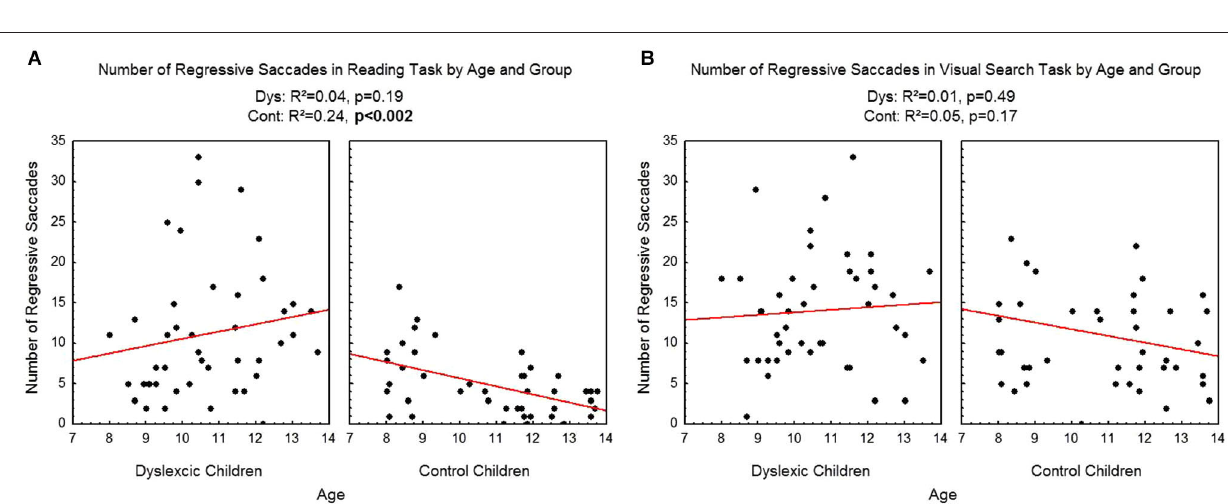
task ( R 2 = 0.05, p = 0.17). There is no effect of age on dyslexic group on reading ( R 2 = 0.04, p = 0.19) nor on visual search ( R 2 = 0.01, p = 0.49)